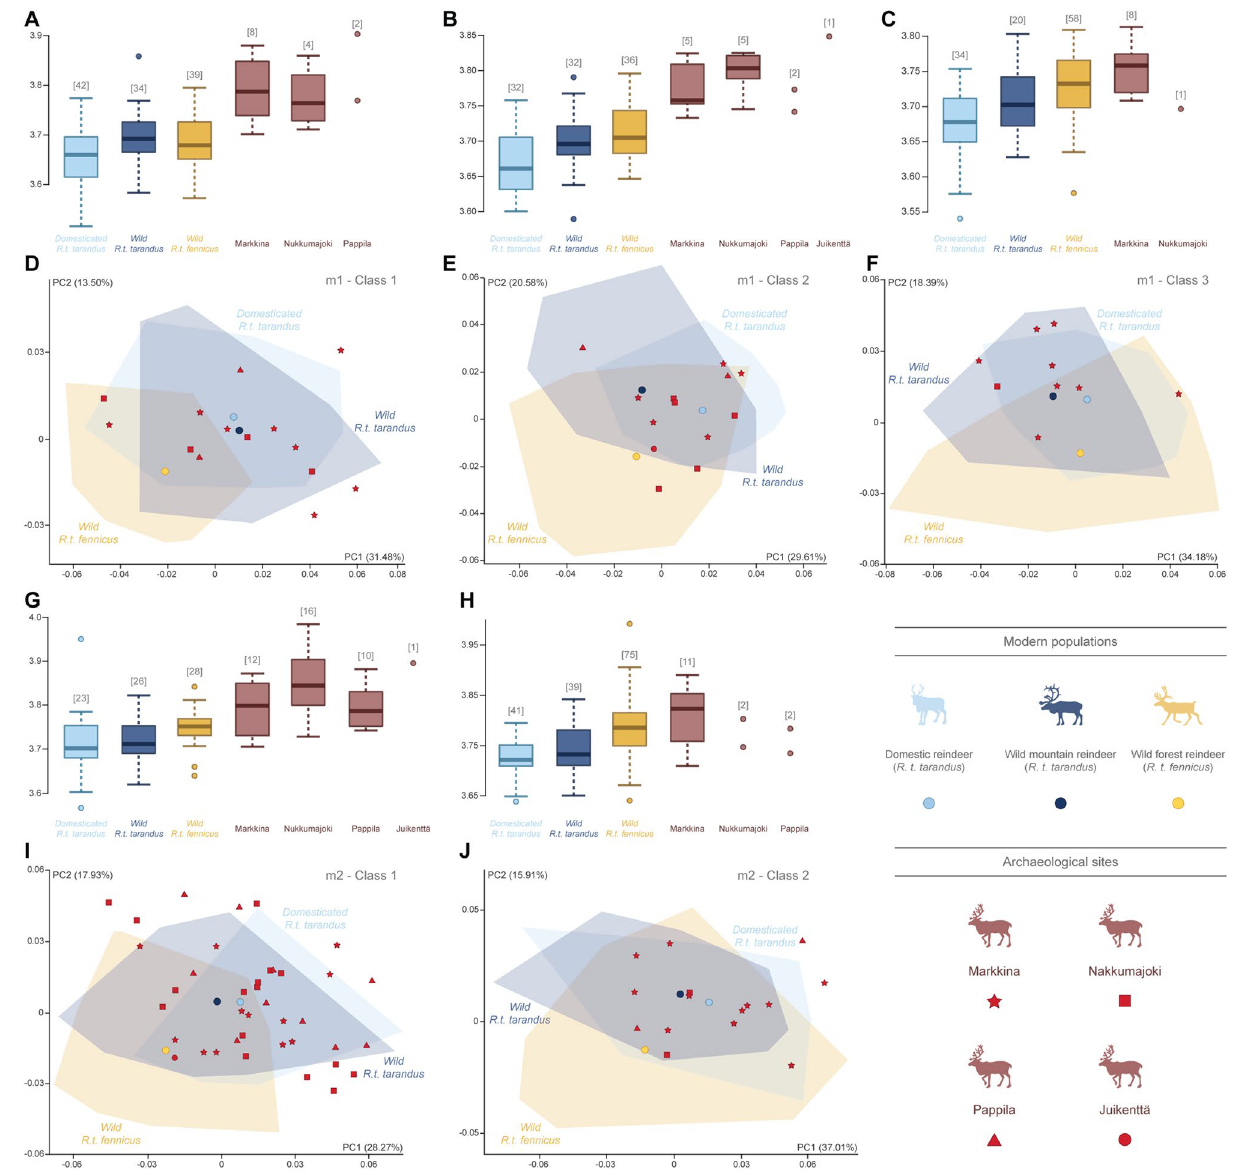
Figure 5. Size and shape analysis of archaeological specimens. Boxplots of the variation in log-transformed centroid size (Csize) according to the tooth wear class for m1-Class1 ( A ), m1-Class2 ( B ), m1-Class3 ( C ), m2-Class1 ( G ) and m2-Class2 ( H ). The numbers in square brackets represent the number of teeth analysed in each category. Scatter plots of the two first axes (PC1 and PC2) of principal component analyses performed on the shape data according to the tooth wear class for m1-Class1 ( D ), m1-Class2 ( E ), m1-Class3 ( F ), m2-Class1 ( I ) and m2-Class2 ( J ). The proportion of the total variance respectively expressed by the axes PC1 and PC2 is indicated in